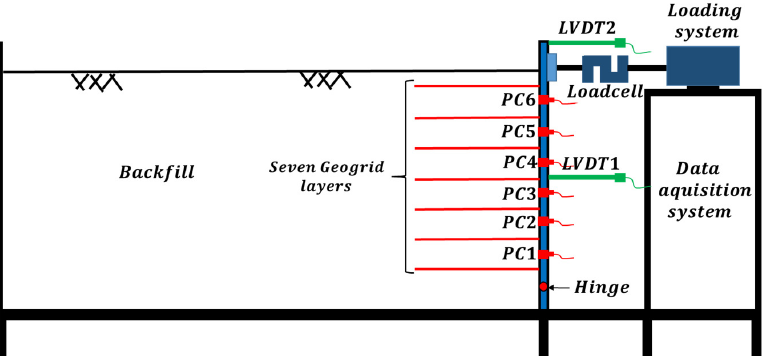
Figure 3. Schematic view of model box, instruments, and data acquisition system.